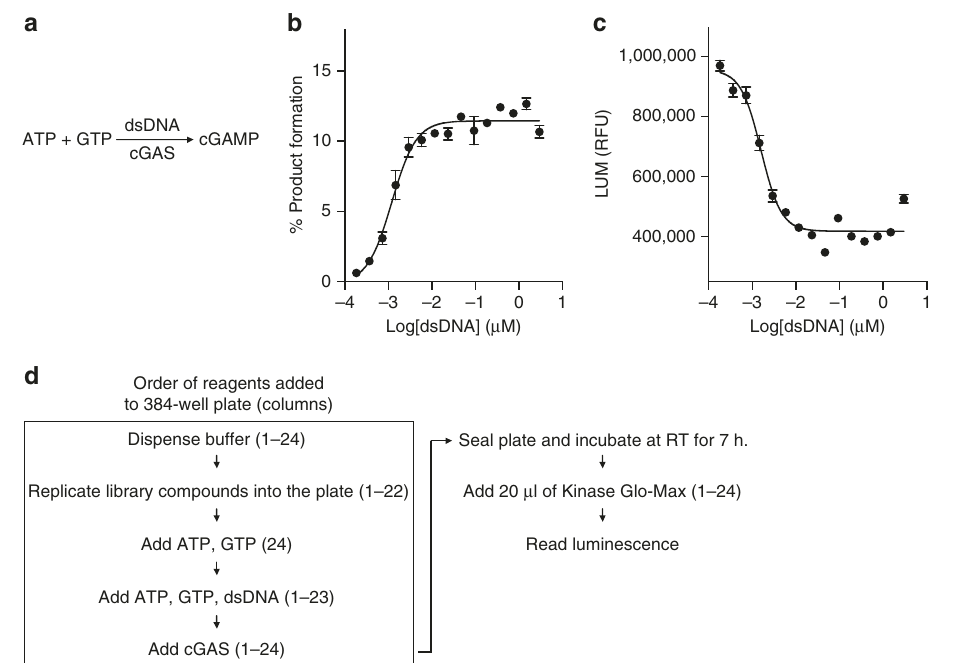
Fig. 1 Establishment of a high-throughput screening assay for identi fi cation of small-molecule h-cGAS inhibitors. a Schematic showing dsDNA-activated cGAS synthesis of cyclic GMP – AMP (cGAMP) from ATP and GTP. b , c Assessment of enzymatic activity of h-cGAS under varying dsDNA concentrations based on RapidFire mass spectrometry (RF-MS) assay ( b ) or ATP-coupled luminescence (LUM)-based assay ( c ). d Schematic for high-throughput screening of small-molecule h-cGAS inhibitors using assay ( c ). Numbers in parentheses indicate the column(s) in plate into which the speci fi ed reagent was dispensed. RT room temperature. ( n = 6 for b and c ; mean ±